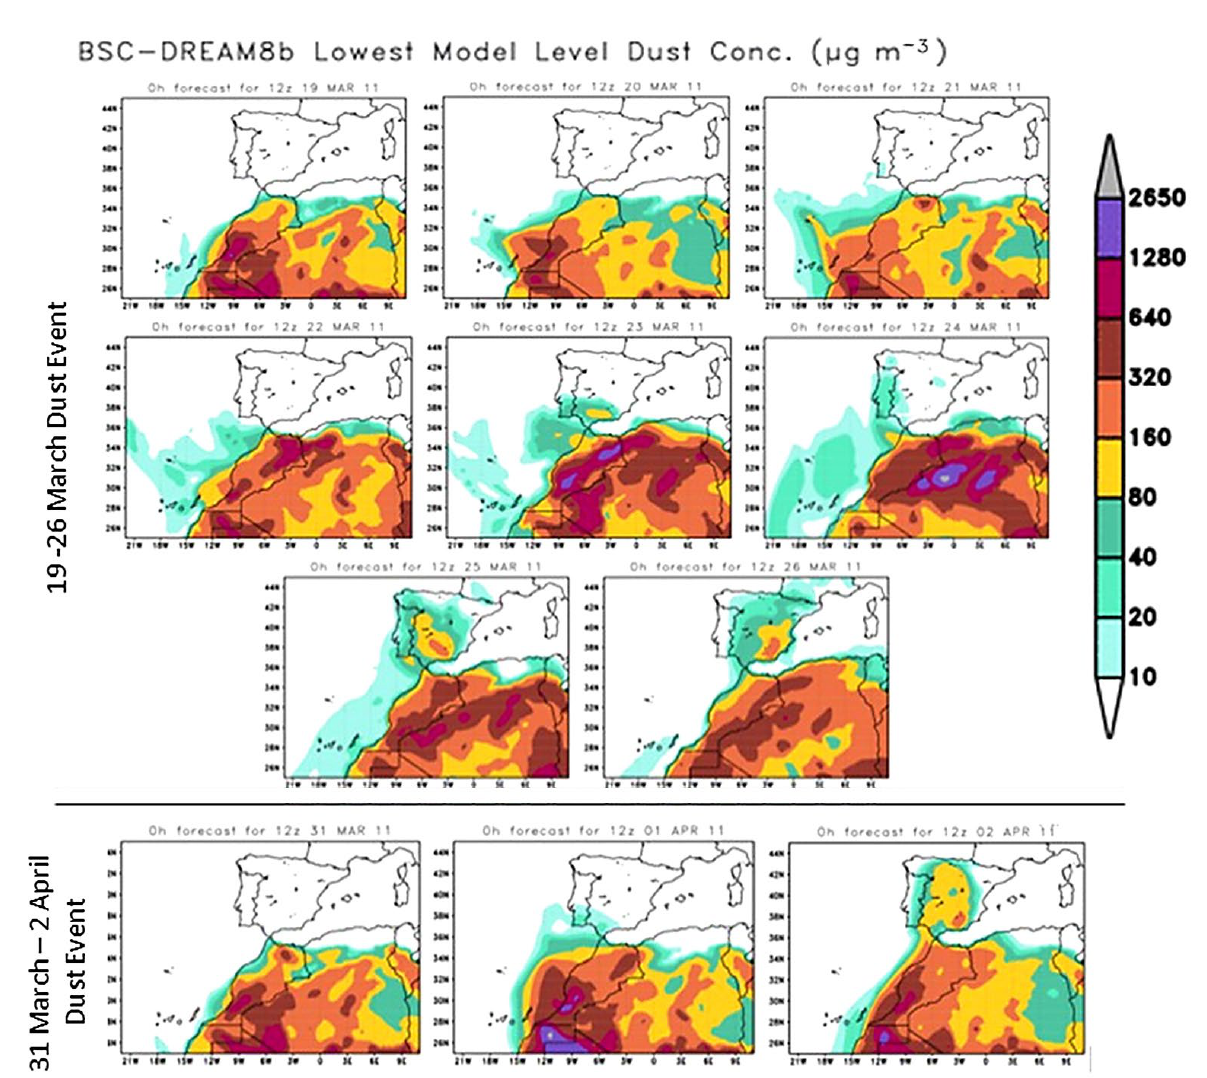
Fig. 8. – Dust events of 19 to 26 March and 31 March to 2 April derived from the DREAM model of the Barcelona Supercomputing Centre (http://www.bsc.es/earth-sciences/mineral-dust-forecast-system). The circle mark indicates Gran Canaria Island, where the samples were taken, and the intense colour (higher concentration) corresponds to the possible source of the dust event (northern Mauritania and western